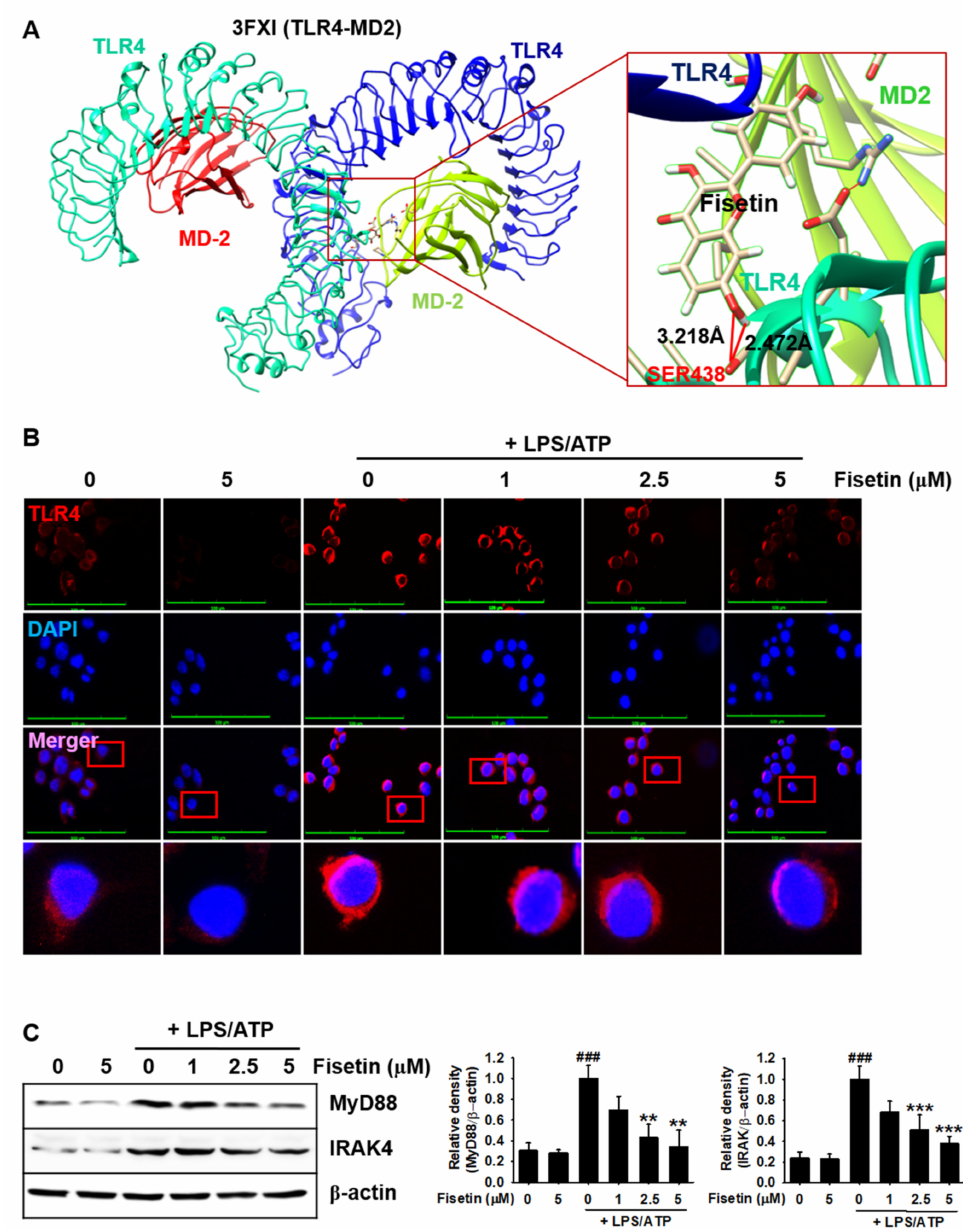
Figure 2. Fisetin probably binds to TLR4 and inhibits the TLR4-mediated intracellular signaling pathway. ( A ) Molecular docking of fisetin (pose 1) with the TLR4/MD2 complex (PDB ID: 3FXI). ( B ) BV2 microglial cells were seeded on 3% gelatin-coated coverslips and treated with the indicated concentrations of fisetin (0–5 µ M) for 2 h prior to stimulation with 1 µ g/mL LPS for 2 h and subsequent stimulation with 1 mM ATP (LPS/ATP) for an additional 2 h. Cells were fixed with 4% paraformaldehyde and immunostained for TLR4 using Alexa Fluor 647-conjugated secondary antibody. The images were captured using a CELENA S Digital Imaging System. ( C ) In a parallel experiment, the total proteins were extracted and western blotting was performed for detecting the expression of MyD88 and IRAK4 proteins. β -Actin was used as a loading control. The results indicate the mean ± standard error median (SEM), and is representative of the results obtained from three independent experiments. ### p < 0.001 vs. untreated cells; *** p < 0.001 and ** p < 0.01 vs. LPS/ATP-treated